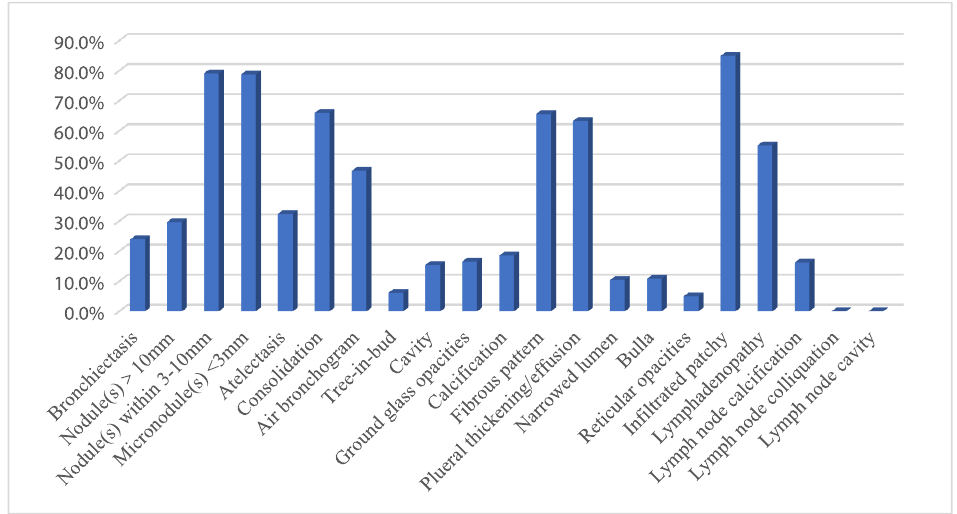
Figure 3: The frequency of radiological features. The radiological fi ndings in patients with atypical pulmonary tuberculosis mimicking bacteria pneumonia were diverse. The relatively common manifestations were in fi ltrated patchy ( 84.9% ) , nodules within 3 – 10 mm ( 79.2% ) , micronodules ( 78.8% ) , consolidation ( 66.0% ) , fi brous pattern ( 65.6% ) , and pleural thickening/e ff usion ( 63.3% )